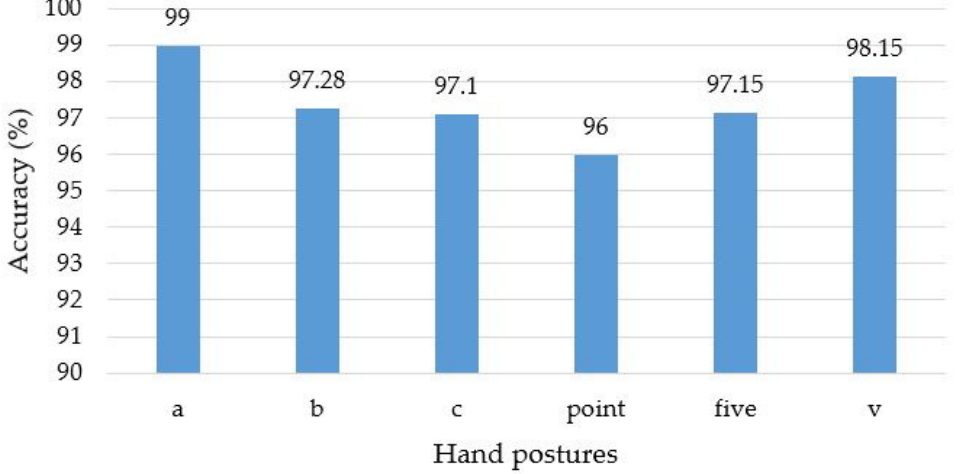
Figure 16. Recognition accuracy of static hand postures using benchmark